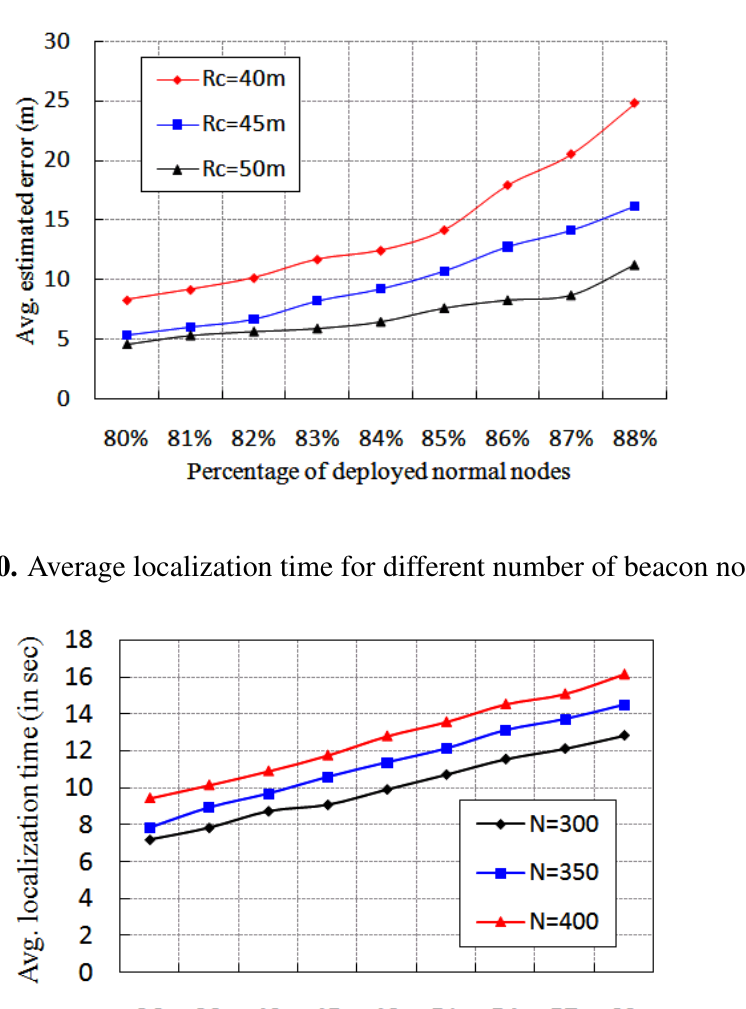
Figure 9. Average estimated localization error for different communication ranges.